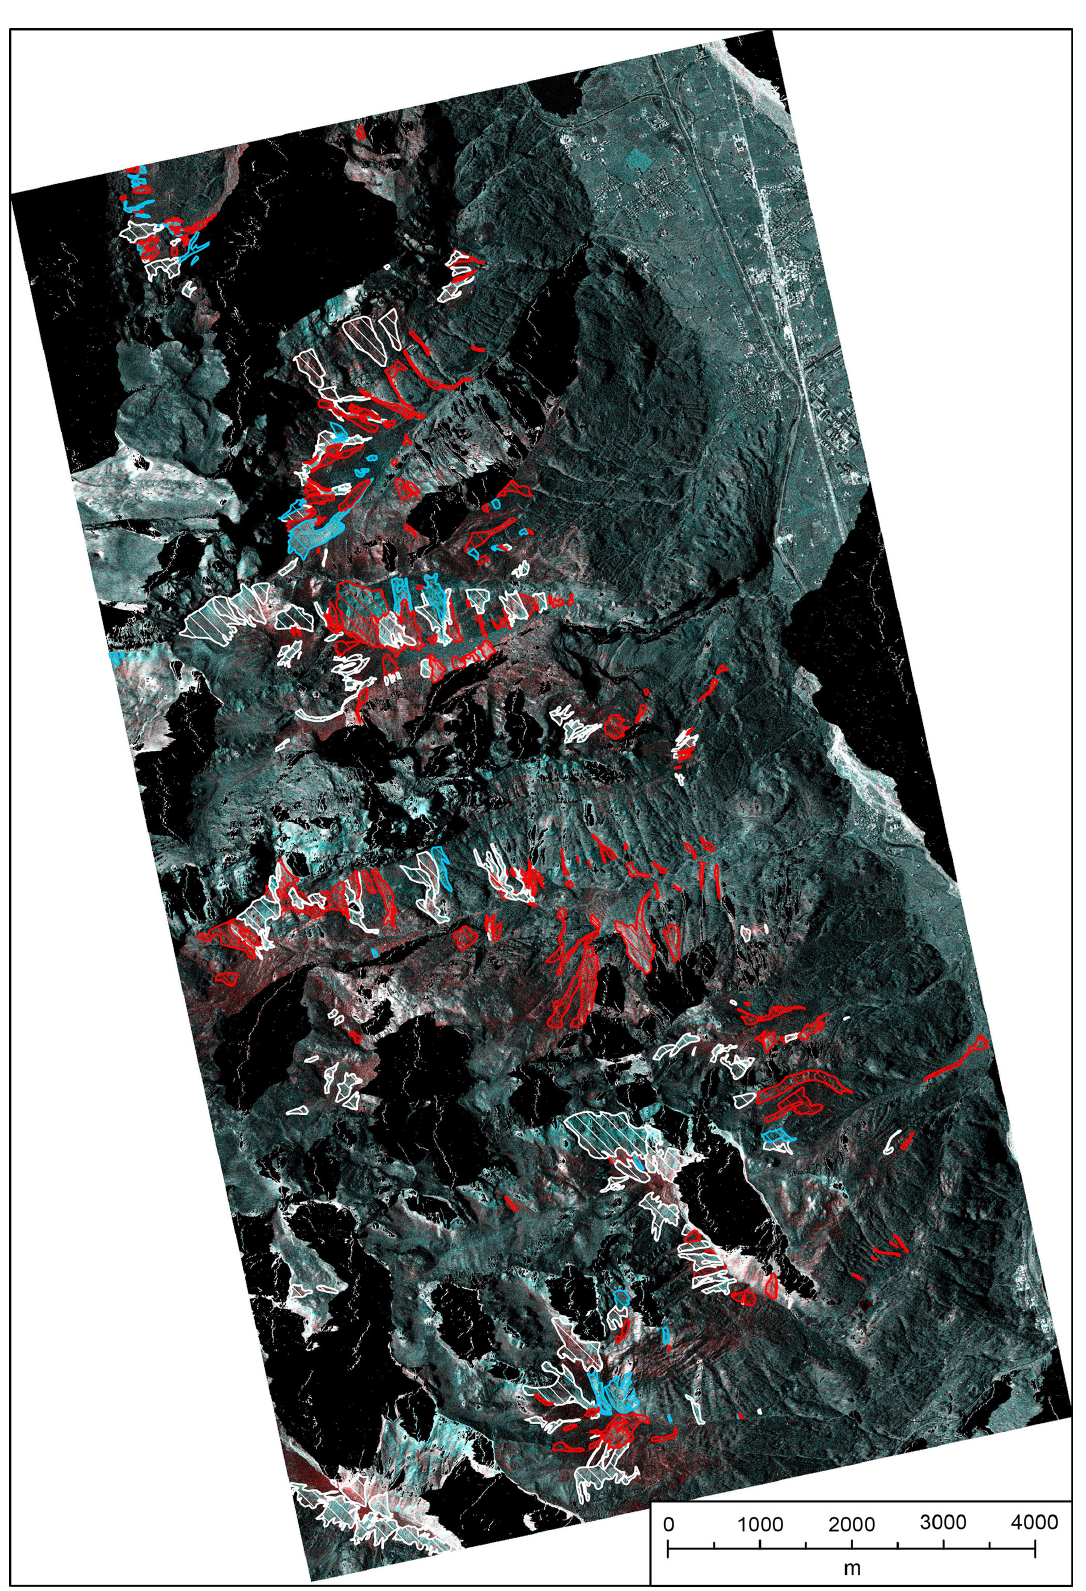
Figure A3. Full extent of the RGB composite image TSX 2018-01-11 vs. 2018-02-02 with manually mapped avalanches. New avalanches are red, old avalanches are blue, and unsure avalanches are white. Areas in the radar layover and shadow are masked out (black). TerraSAR-X image orthorectified with the swissALTI3D © 2019 swisstopo (JD100042), reproduced with the authorization of swisstopo